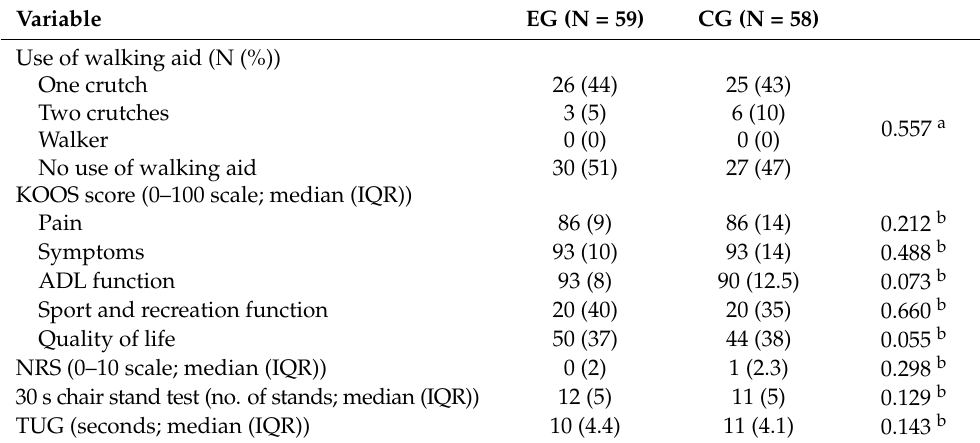
Table 2. Walking aid use, KOOS, NRS, 30 s chair stand test and TUG results on 21st day of rehabil- itation.